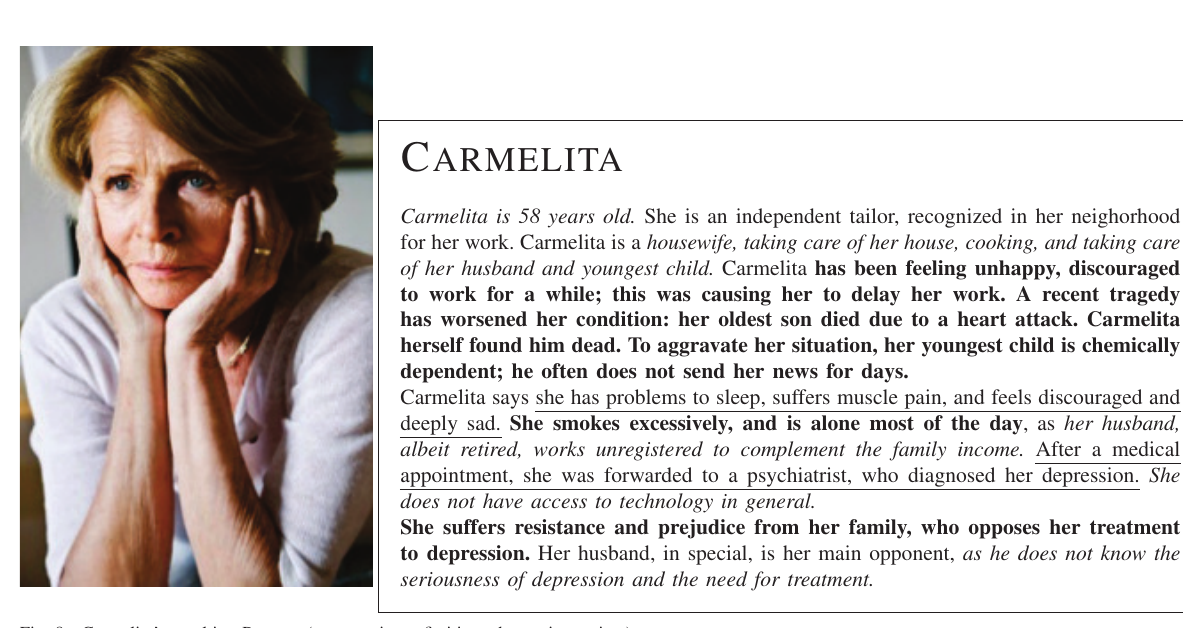
Fig. 8. Carmelita’s resulting Persona (representing a fictitious depressive patient).